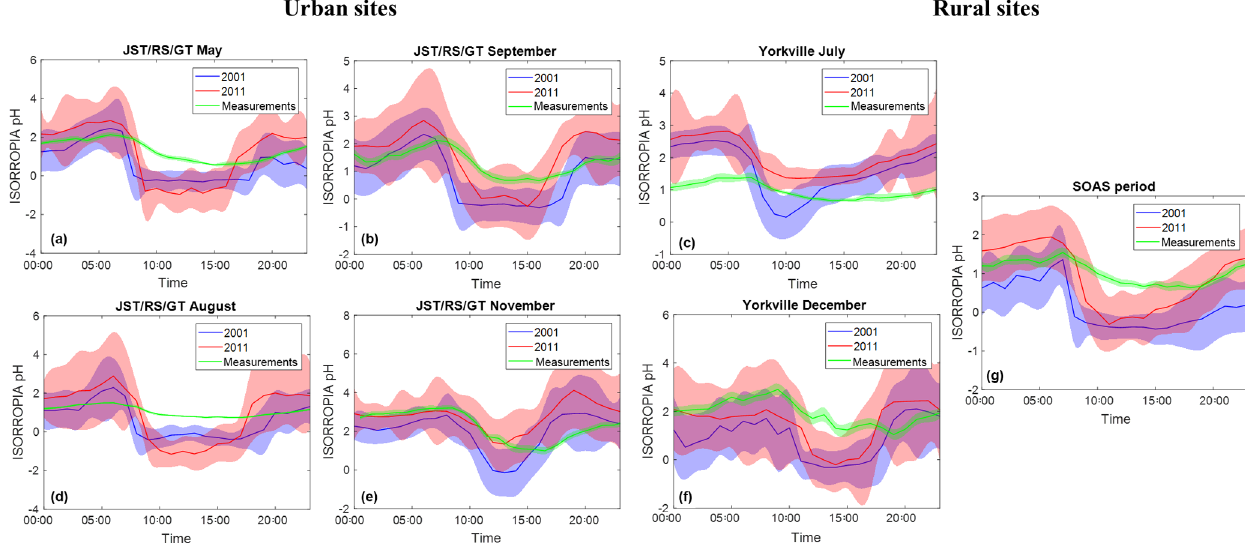
Figure 2. pH diurnal profiles for May (a) , August (b) , September (c) and November (d) at JST/RS/GT, July (e) and December (f) at YRK and for the SOAS campaign period (g) . Blue and red lines are the offline ISORROPIA simulated pH using CMAQ concentrations for 2001 and 2011 respectively, while the shaded areas are 1 model standard deviation. The green line represents the pH calculated through the thermodynamic analysis of the measurements (found in Guo et al., 2015) and the shaded area is the standard